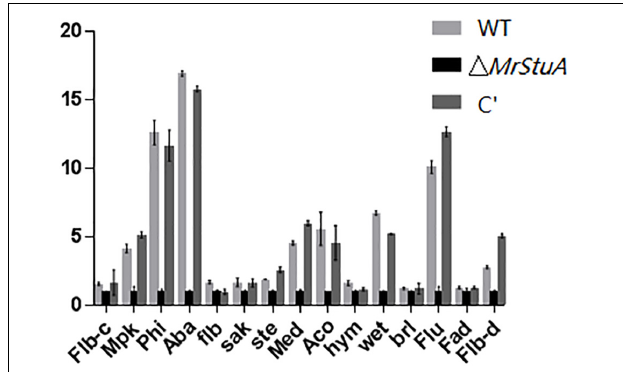
FIGURE 3 | qRT-PCR of the expression of sporulation related genes in the (cid:77) MrStuA strain.